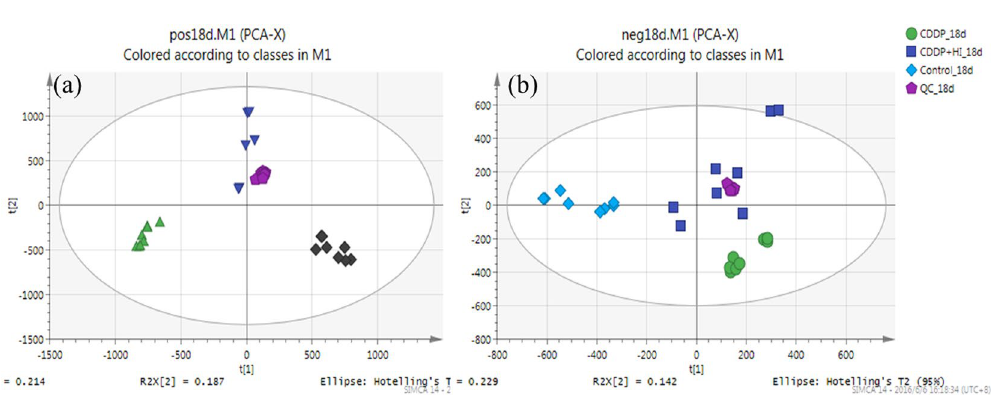
Figure 3. PCA score plots of metabolic profiling of urine samples in positive ion mode ( a ) and negative ion mode ( b